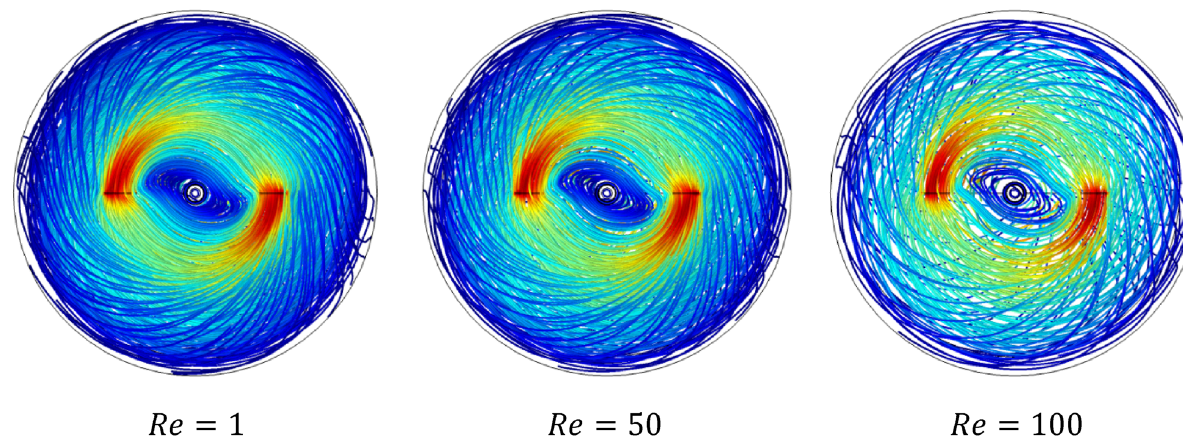
Figure 22. 2D streamline distribution along stirred vessel for Bn = 1 with inertia variation